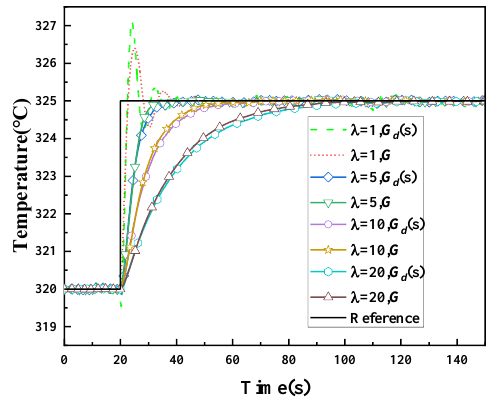
Figure 14. Influence of delay on different controller parameters.